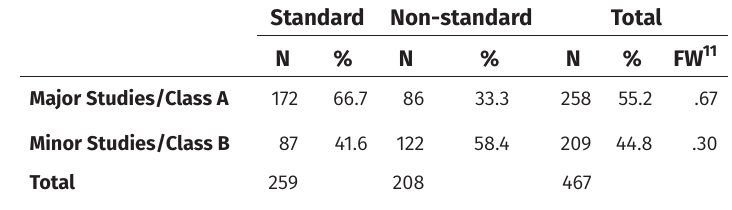
Table 2: Use of standard and non-standard variants depending on the level of education/socio- economic stratum.